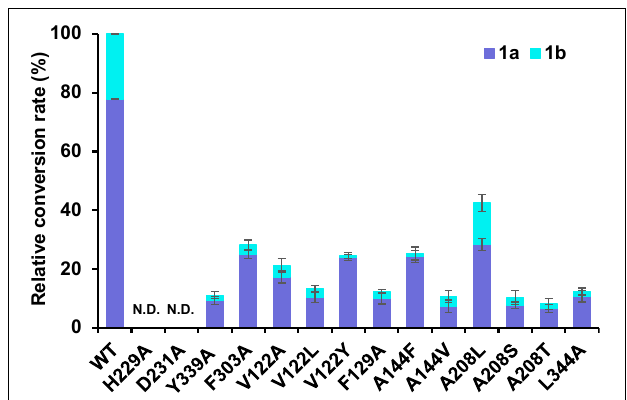
FIGURE 6 | The relative conversion rates of wild-type (WT) Sm2OGD25 and mutants. In vitro assays of Sm2OGD25 and its variants using sugiol (1) as the substrate. N.D. represents mutants with no detected activity. Error bars indicate standard deviation of three independent replicates.